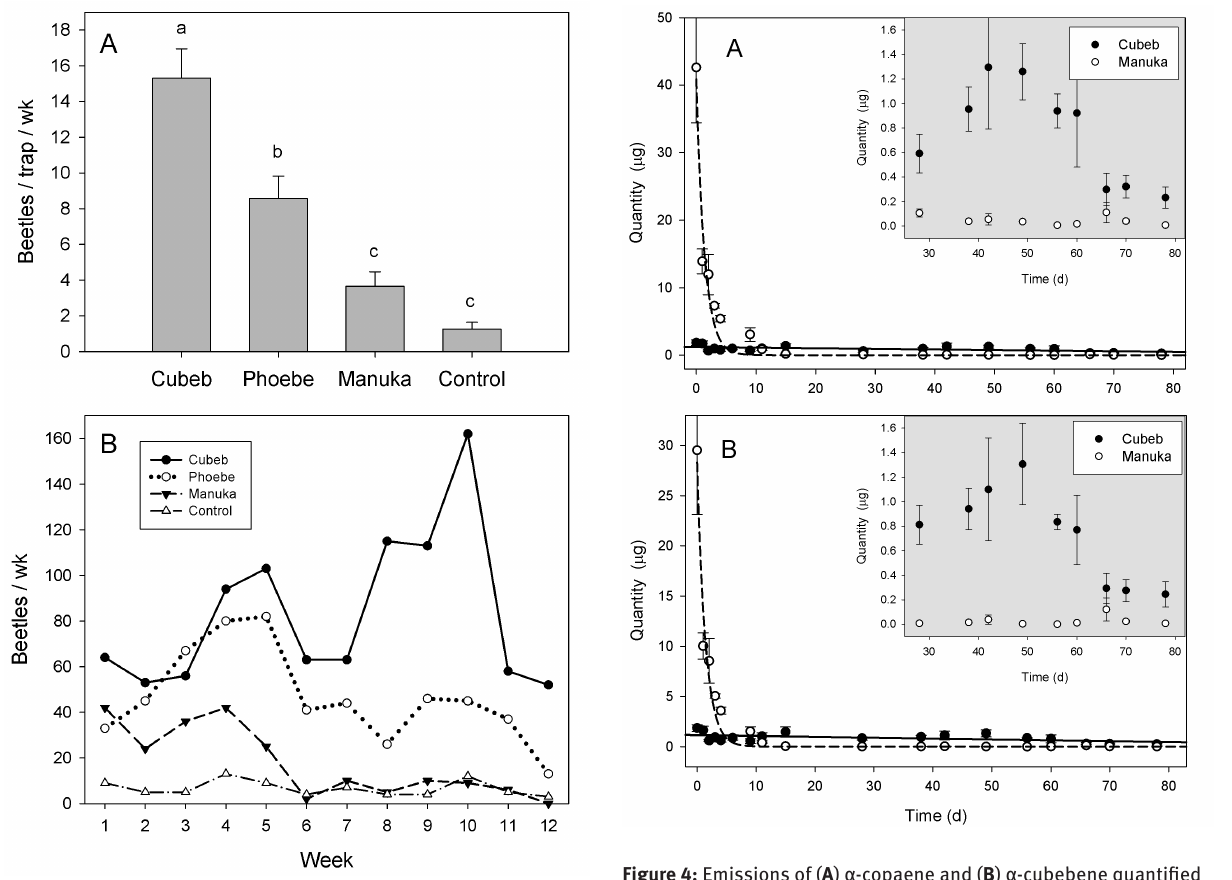
Figure 4: Emissions of ( A ) α-copaene and ( B ) α-cubebene quantified over time from commercial oil lures field-deployed for 12 wk in Miami-Dade County, FL, USA. Inset enhances the scale for emissions beginning at 4 wk, the point at which manuka lures lost efficacy for attraction of X. glabratus in field tests. Volatiles were isolated by super-Q collection, analyzed by GC-MS, and identified by comparison of Kovats retention index with synthetic chemical; adapted from